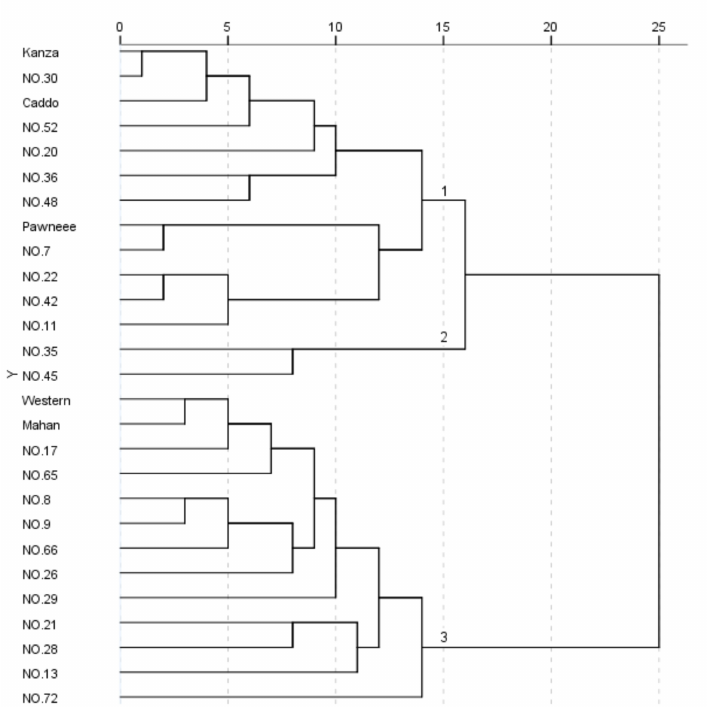
Figure 2. Hierarchical cluster analysis of pecan fruits of different cultivars. The numbers 1, 2 and 3 in the figure when the squared Euclidean distance is 15, the tested pecan are divided into three